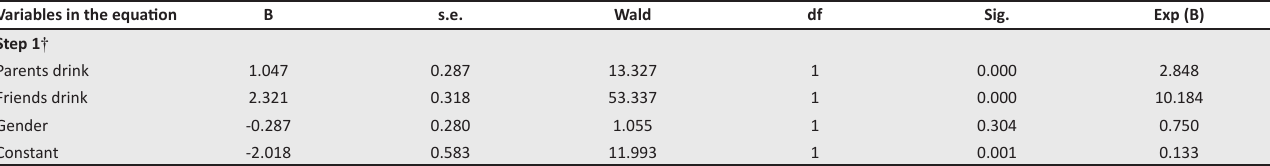
TABLE 3: Binary logistic regression analysis between learners who drink, gender, parents and friends who drink alcohol. Variables in the equation B s.e. Wald Sig.